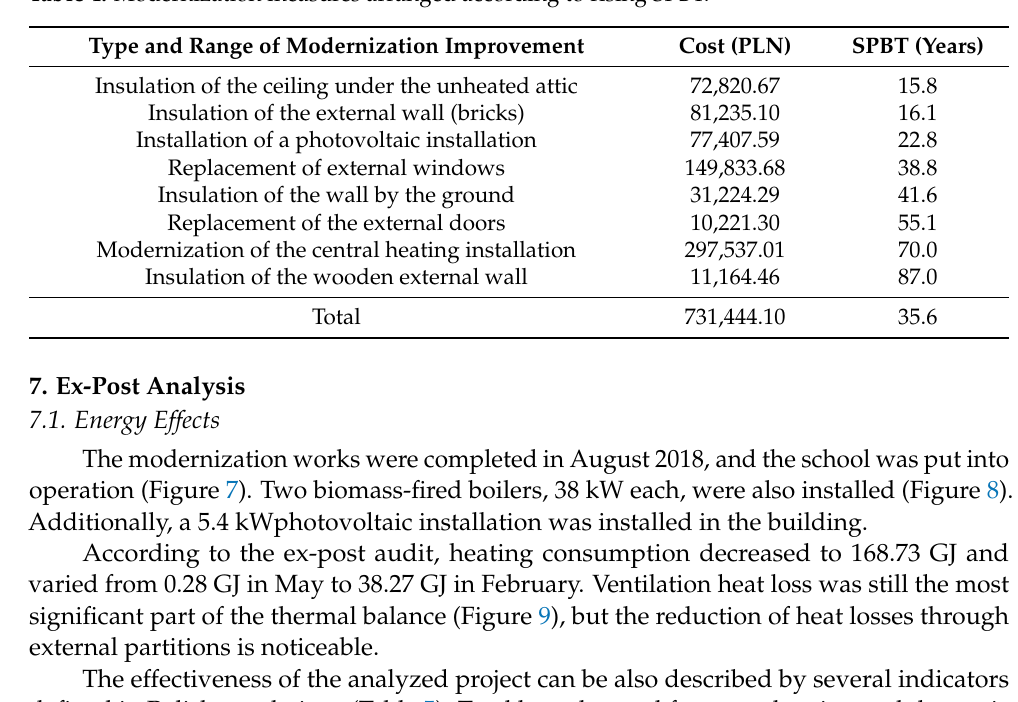
Table 4. Modernization measures arranged according to rising